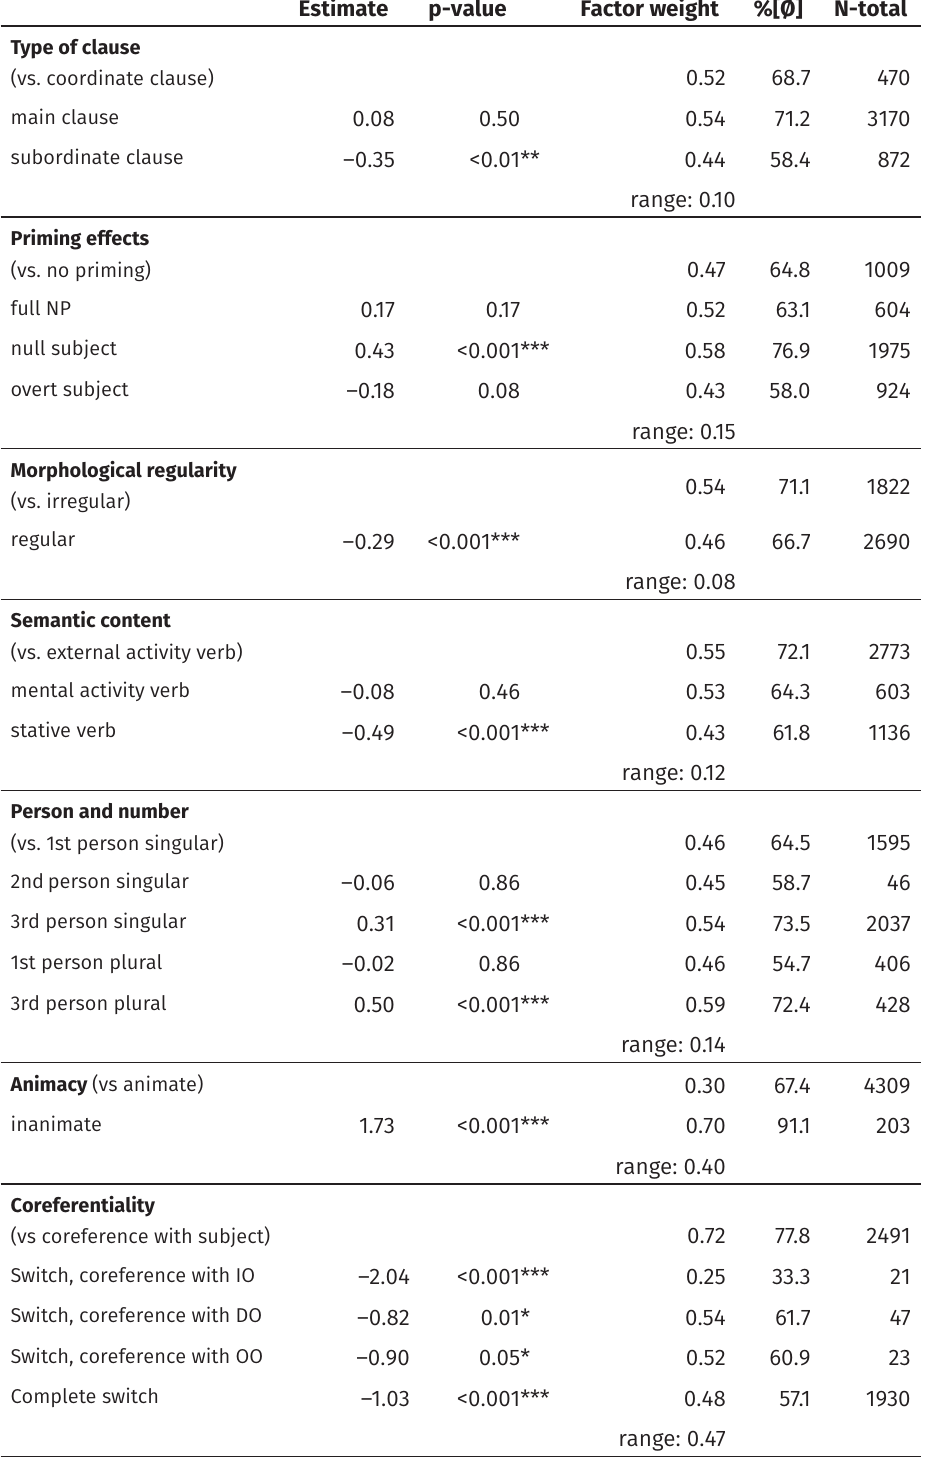
Table 13: Significant linguistic factors for the use of null subject (intercept = 1.48; N = 4512; [Ø] = 68.5%).